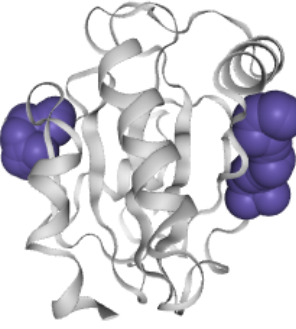
Figure 13. Substrate binding site and allosteric site of GPX4. The protein molecule is shown as a gray cartoon representation. Each pocket is shown in